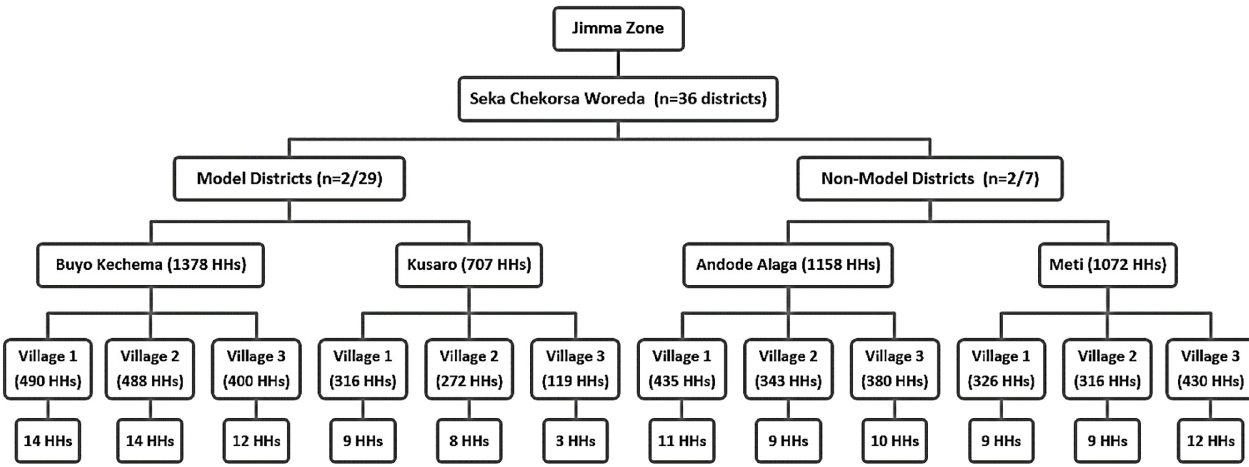
Fig 1. Diagrammatic representation of the multi-stage sampling technique used to select individuals in model and non-model HHs. Key: HHs- Household heads.